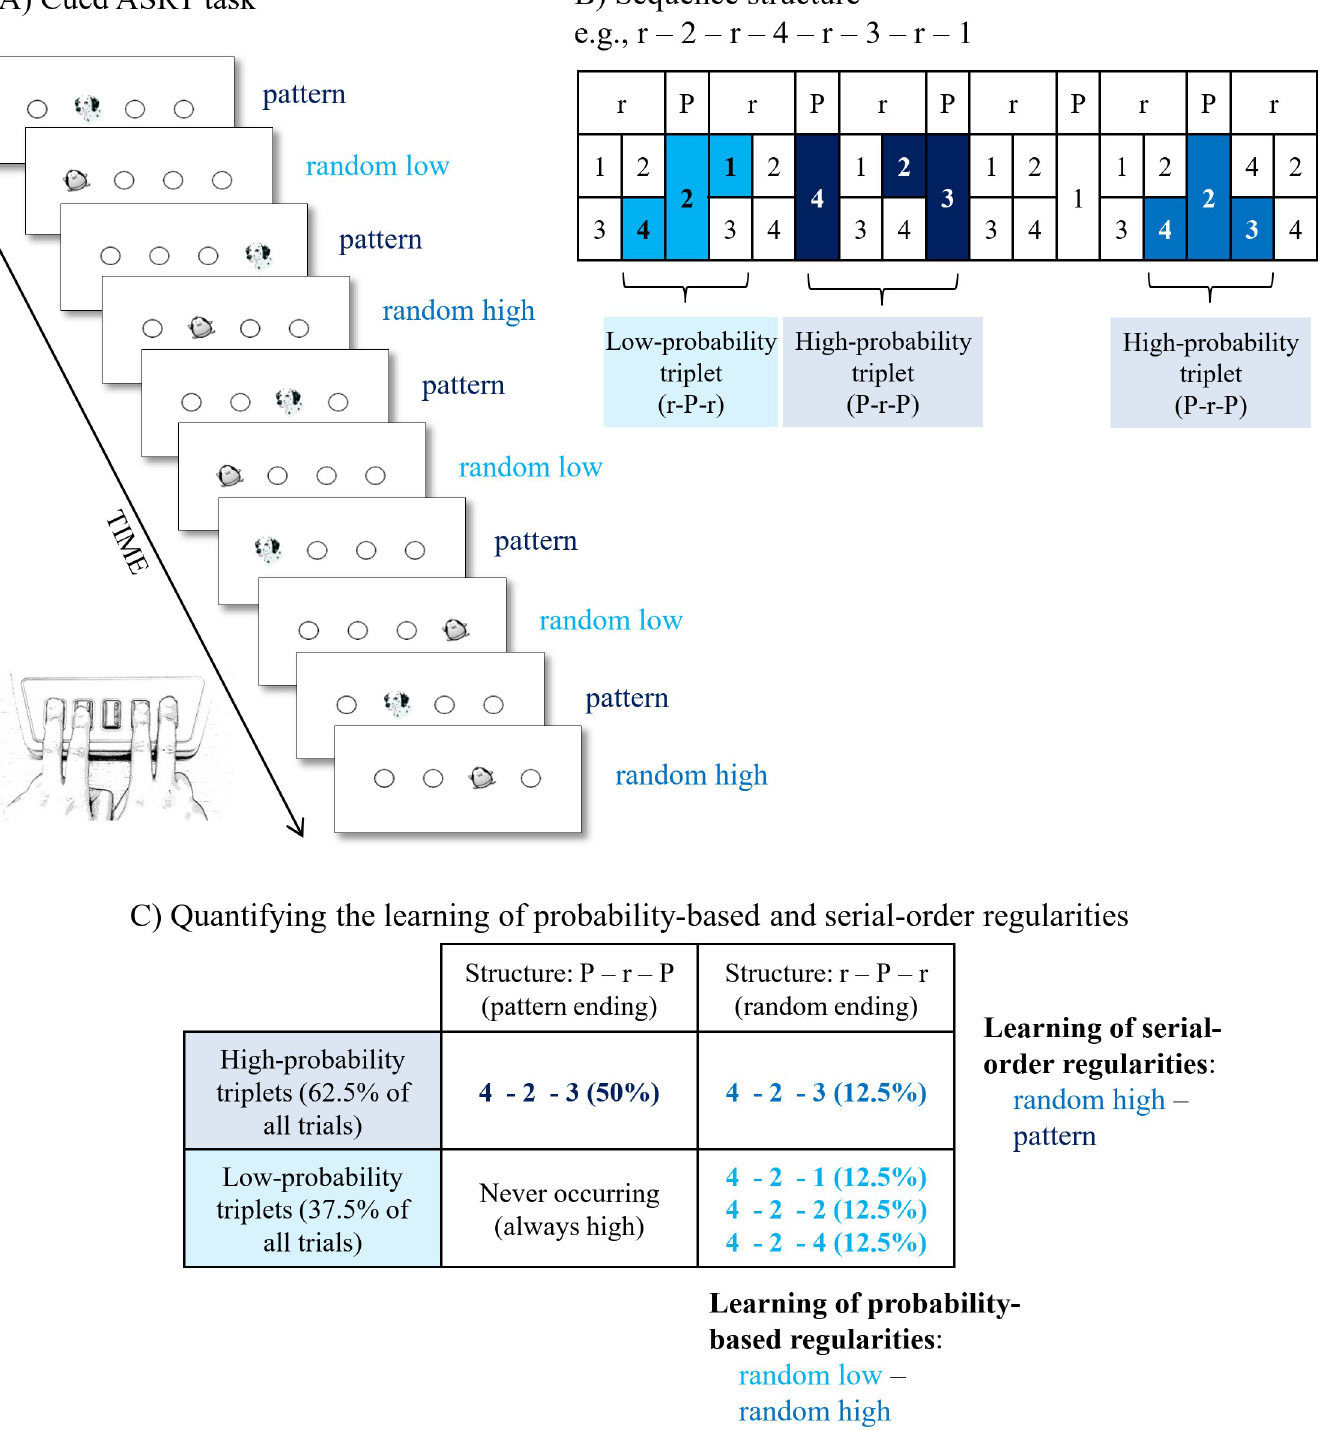
PLOS ONE | https://doi.org/10.1371/journal.pone.0253123 June 15,